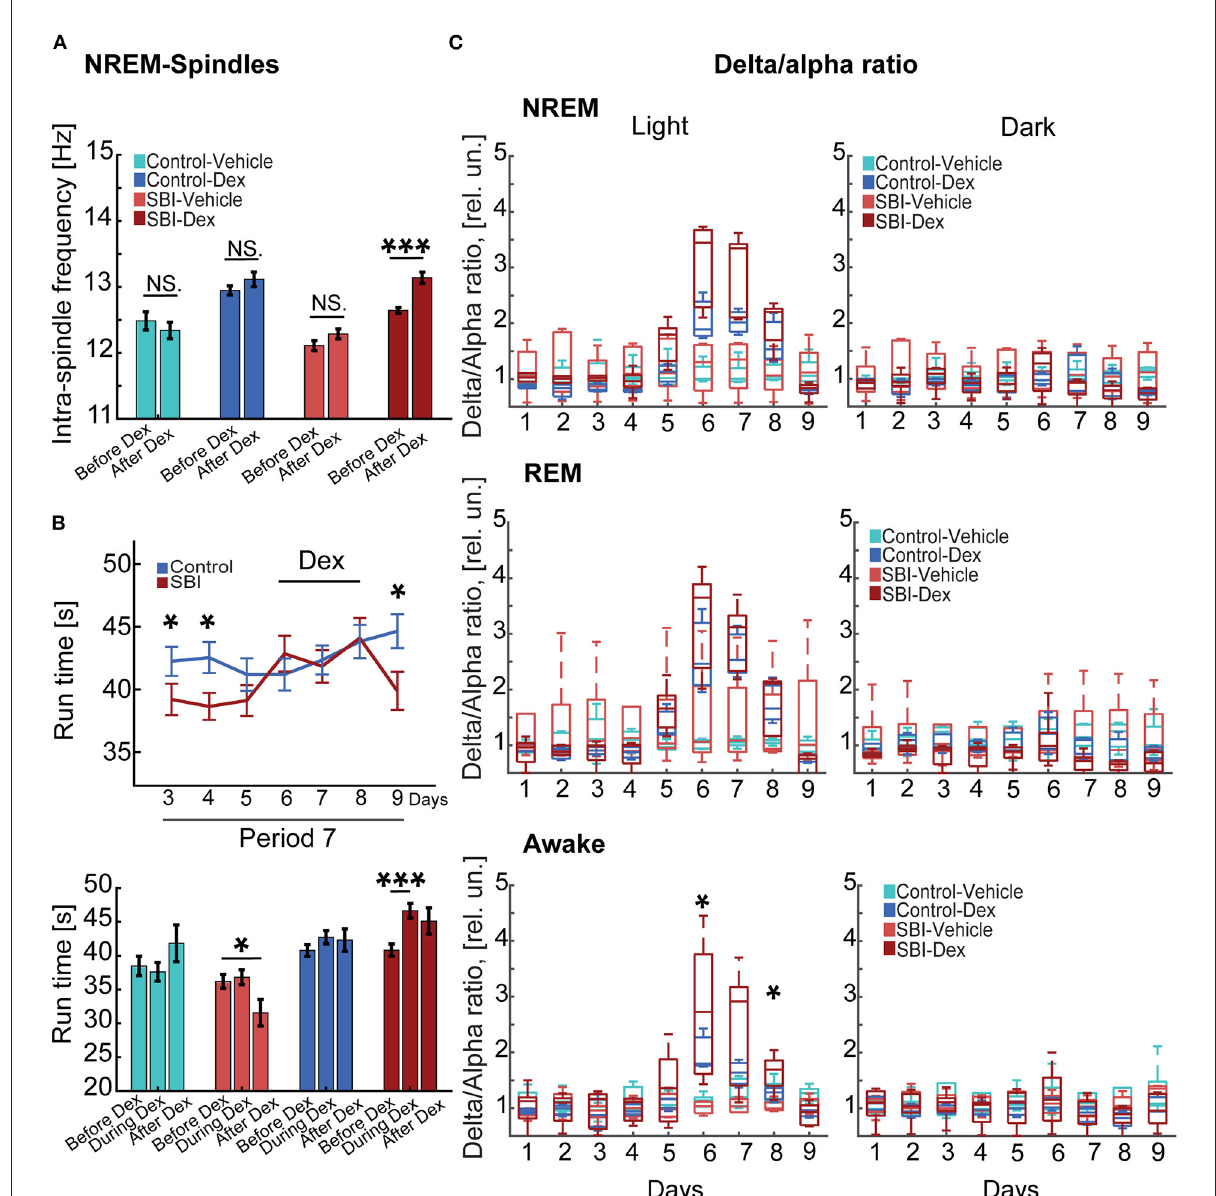
FIGURE5 Dex-mediated sleep phase modulation ameliorates motor tasks. (A) Depicts changes in the intra-spindle frequency tracked for 24h 3 days before and 3 days while injecting Dex injection (0.15 mg/Kg) in control mice injected with vehicle ( n = 5), control mice injected with Dex ( n = 4), SBI mice injected with vehicle ( n = 4), and SBI mice injected with Dex ( n = 5). (B) The upper panel shows the averaged (mean ± S.E.M.) run time on rotarod in seconds (s) of control ( n = 21) and SBI mice ( n = 27). In addition, we showed the run times 3 days before, during, and a day after Dex treatment (lower panel) including control mice injected with Dex ( n = 11), control mice injected with vehicle ( n = 10), SBI mice injected with Dex ( n = 17) and SBI mice injected with vehicle ( n = 11). (C) Displays box plots of the delta/alpha ratio scores obtained from control-vehicle ( n = 5), control-Dex ( n = 4), SBI-vehicle ( n = 4), and SBI-Dex ( n = 5) during the NREM, REM, and awake states. Each state was divided into 12h of light and dark cycles. We applied Kruskal–Wallis and Dunn’s test with Bonferroni correction to establish the effect of Dex on intra-spindle frequency, rotarod performance, and delta-alpha ratio. * p < 0.05, *** p < 0.001, and non-significant statistical differences (N.S).